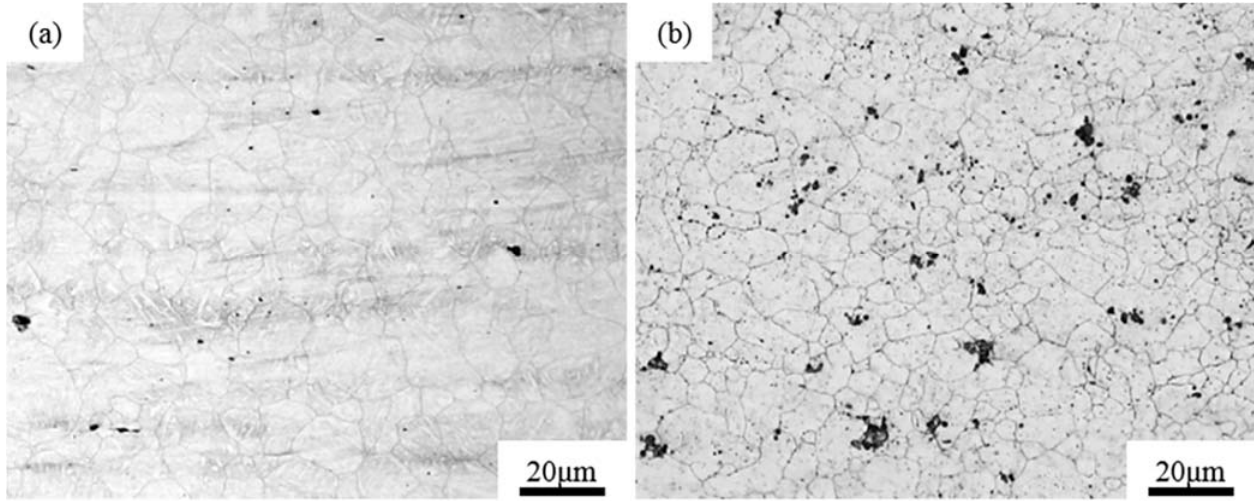
Figure 4. The morphology of prior austenite grain in the same conditions: ( a ) Al ‐ Steel; ( b ) Zr ‐ Steel. The microstructure of the Al-Steel and the Zr-Steel are shown in Figure 5. The microstructure mainly consisted of tempered martensite. The diffusion process of martensite disintegration and carbide transformation occurred during the tempering of the quenched carbon steel, resulting in the formation of a ferrite–cementite structure with a different dispersion and morphology [49]. Because two kinds of experimental steels were tempered at high temperature, the tempered martensite was formed by irregular cementite plate laths, which were filled on the ferrite matrix. The complete martensite structure after high temperature tempering was recognized as the best structure for SSC resistance [50]. The average diameters of the tempered martensite grain in the Al-Steel and the Zr-Steel were 8.2 µ m and 3.8 µ m, respectively. It was obvious that the microstructure of the Al-Steel was large, but the grain refinement effects of the tempered martensite were quite strong in the Zr-Steel. The martensite grain size was related to the phase transition temperature and prior austenite grain size, whereas the width of the martensite was due to its low transformation temperature, and the length of the martensite lath was restrained by the prior austenite grain boundary [51,52]. The tempered martensite grain of the Zr-Steel was finer, which proves that the oxide metallurgy process can refine the grain, thus promoting the simultaneous improvement of the strength and toughness of Zr ‐ Steel.